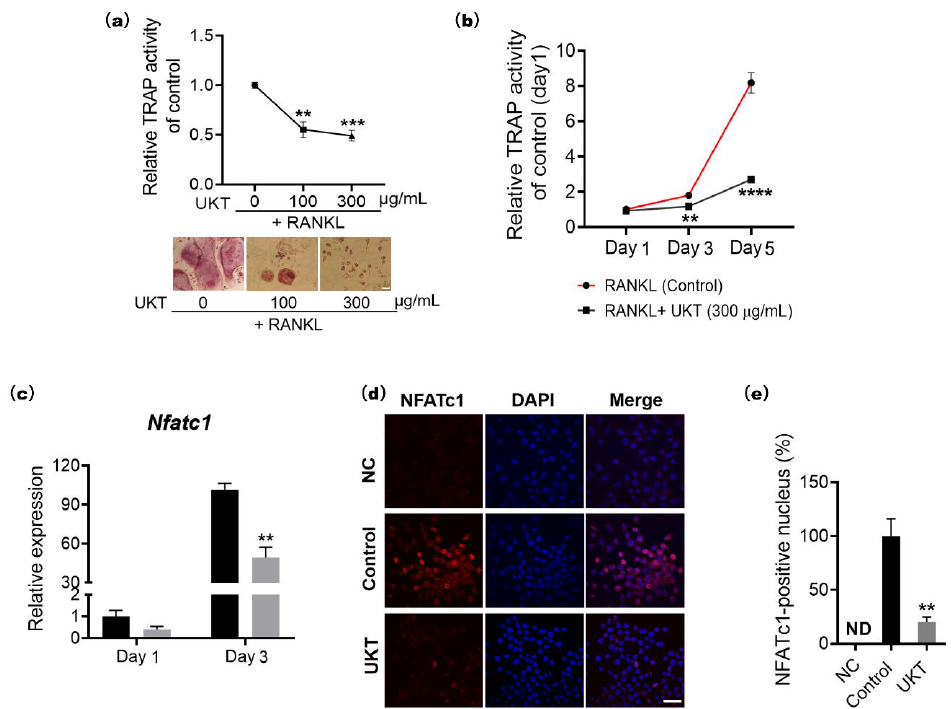
Figure 2. Unkeito (UKT) affects tartaric acid-resistant phosphatase (TRAP) activity in a concentration-dependent manner and at early stage of osteoclast differentiation. ( a ) RAW 264 cells treated with sRANKL (100 ng/mL) with or without UKT (100 and 300 µg/mL) for five days ( n = 4; scale bar = 25 µ m); ( b ) RAW 264 cells (1 × 10 3 cells/96-well) treated with sRANKL (100 ng/mL) with or without UKT at 300 µ g/mL for one, three, or five days ( n = 4); ( c ) mRNA expression level of Nfatc1 normalized to that of Gapdh ; ( d ) protein abundance of NFATc1 72 h after RANKL stimulation in the presence or absence of UKT ( n = 3; scale bar = 20 µ m); ( e ) intra-nuclear abundance of NFATc1. Error bars represent ± standard error of the mean. ** p < 0.01; *** p < 0.005; **** p < 0.0001, versus control groups on the same day. Black box: control; gray box: UKT; NC: negative control; ND: not